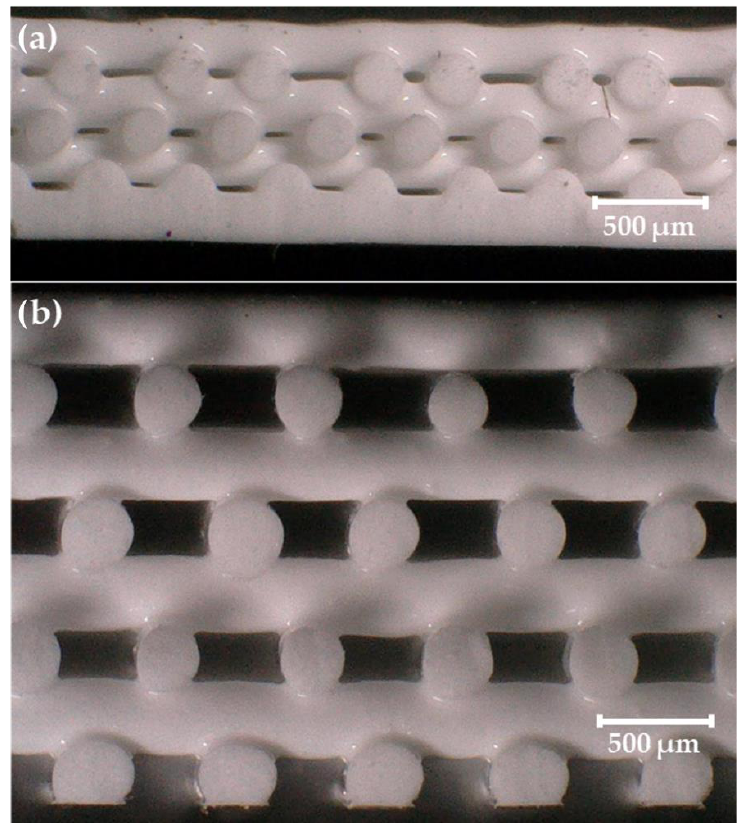
Figure 6. Side view microscope images of 60 wt% Gd 2 O 3 FCT prints using: ( a ) a 250 µm nozzle with 500 µm center-to-center strut distance ( η = 2) and ( b ) a 410 µm nozzle with 750 µm center-to-center strut distance ( η = 1.829).